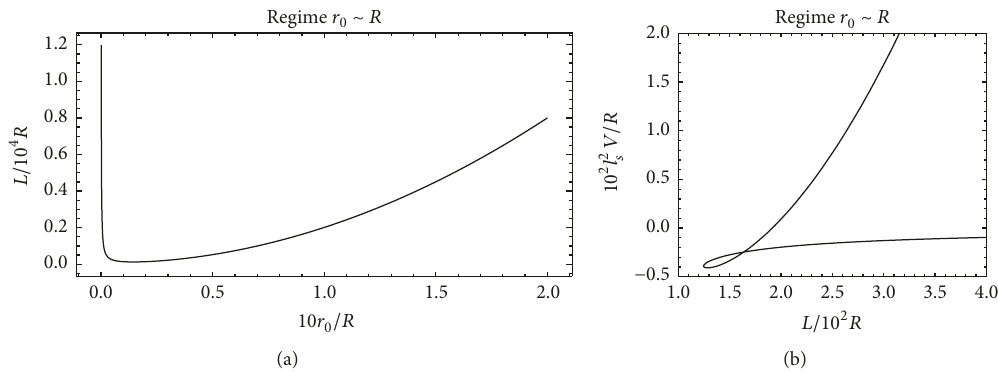
Figure 5: (a) 𝐿/𝑅 versus 𝑟 0 /𝑅 where 𝑟 0 /𝑅 < 0.2 . (b) Transition of the potential interaction. Here, in both panels 𝑟 1 /𝑅 = 10 5 for the D3 branes.